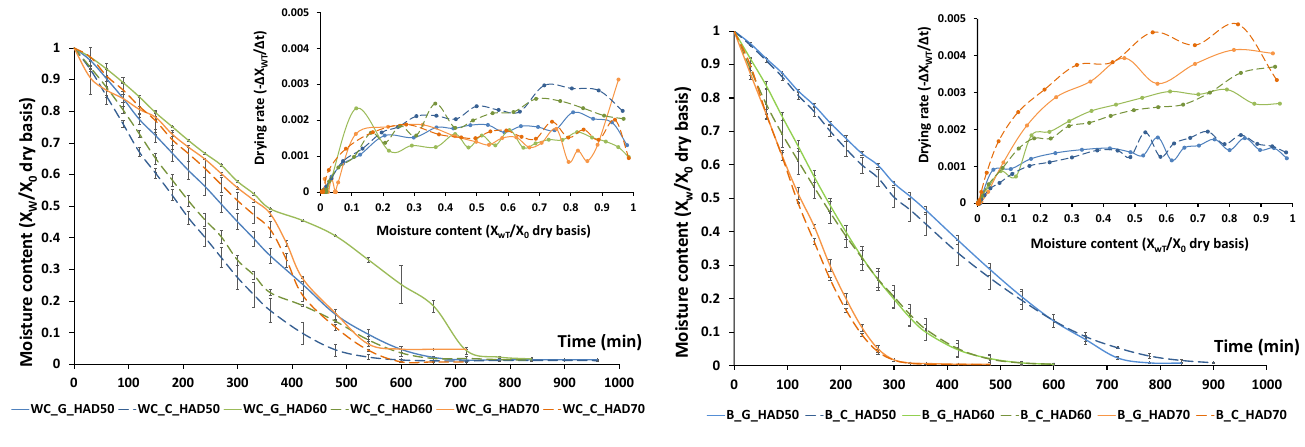
Figure 1. ( a ) Drying curves (moisture content vs. time) and drying rate (drying rate vs. moisture) curves of ground and chopped white cabbage outer leaves ( a ) and broccoli stems ( b ). WC: white cabbage; B: broccoli; G: ground; C: chopped; HAD: hot-air drying at 50, 60 and 70 °C.